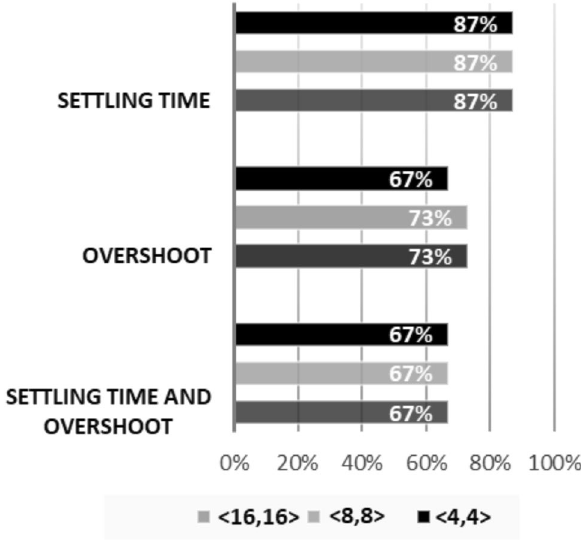
Figure 5. We present the percentage of success in experiments considering the settling time and overshoot specifications. We obtain the highest success rate (around 87%) when synthesizing digital controllers concerning settling time, while the experiments that tackle only overshoot varied from 67% to 73%, depending on the FWL format. Lastly, for the experiments considering both requirements, a success rate of 67% was obtained for all the analyzed FWL